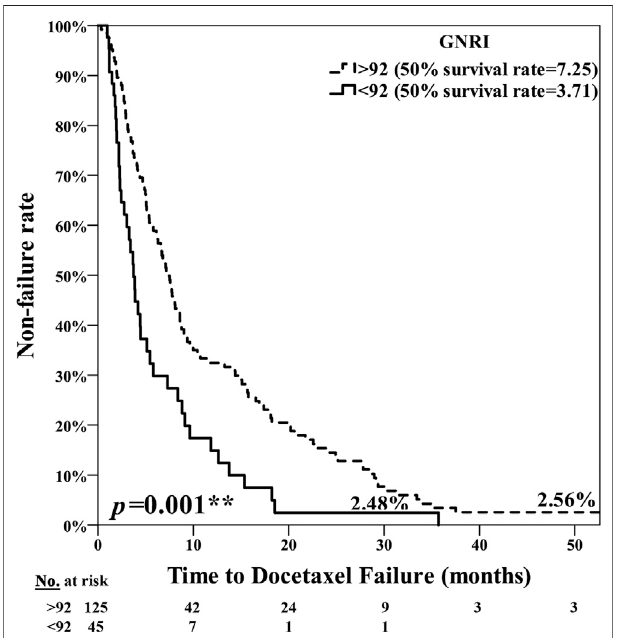
FIGURE1 | Kaplan-Meier curve for PSAProgression Free Survival(PFS) among the normal nutrition group (GNRI ≥ 92.0) and poor nutrition group (GNRI < 92.0), median 7.25 months vs. 3.71 months, respectively ( p (cid:1) 0.001**).